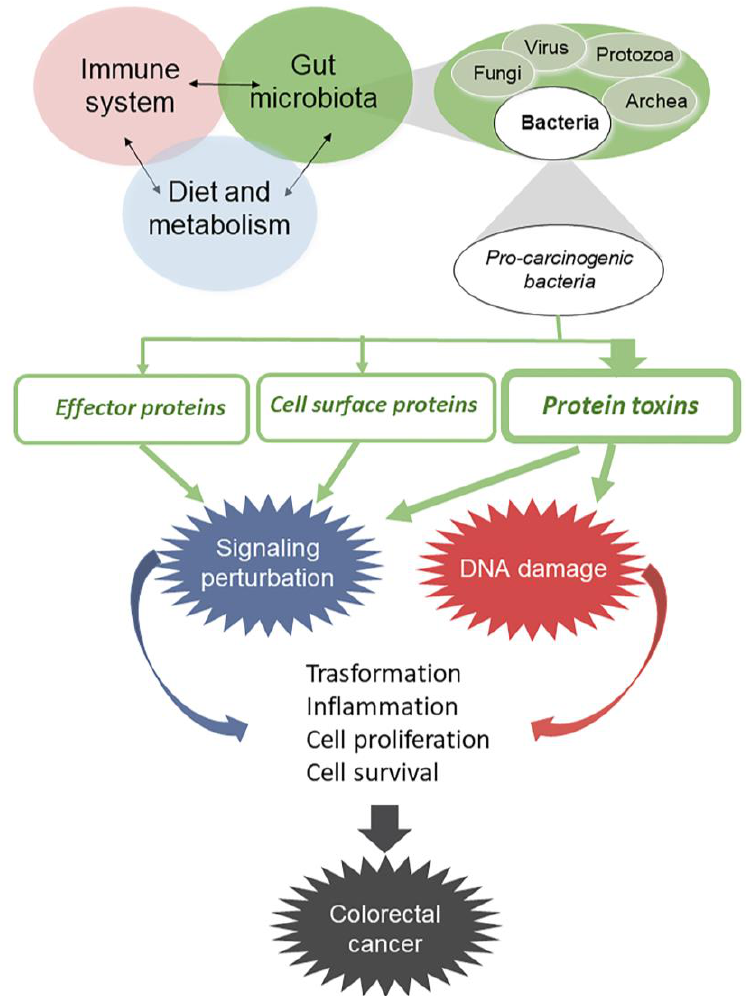
Figure 2. Role of bacterial products in colorectal cancer (CRC). Dysregulation of gut microbial balance, in association with inflammatory and environmental events, is recognized as one of the risk factors for CRC. As a side effect, protein toxins produced by pathogenic bacteria can have a pro-carcinogenic activity through the direct attack to DNA, with consequent genomic instability, or through alterations of cell signaling, that stimulate proliferation and induction of cell death resistance. Effectors proteins and bacterial cell surface proteins are also important pro-carcinogenic virulence factors for CRC development. Different types of arrows are used for protein toxin and effector proteins/cell surface proteins.